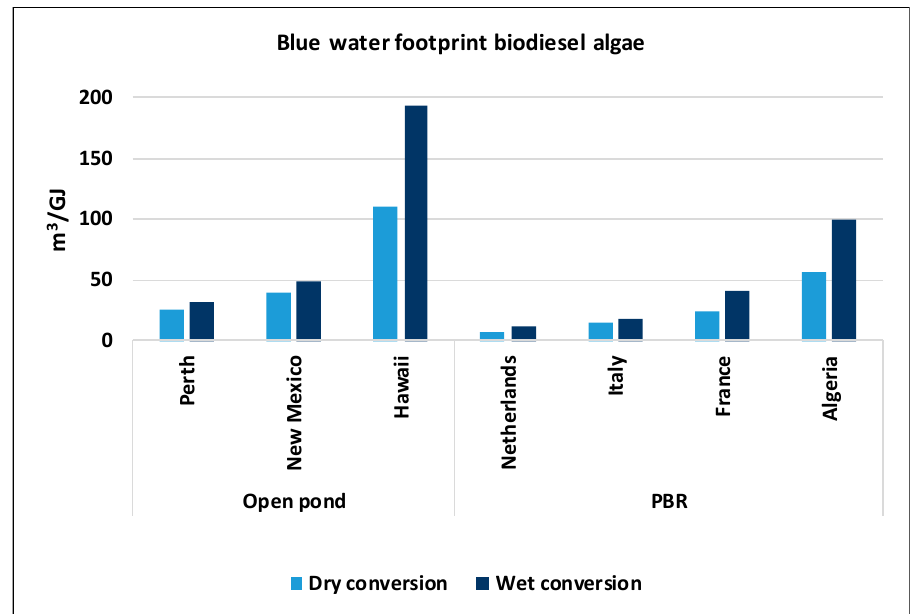
Figure 4. Blue water footprints of biodiesel from algae from seven locations and two production technologies (source: Gerbens-Leenes et al. [13]; PBR is photo bioreactor).